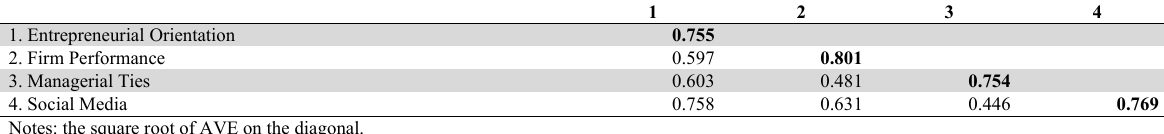
Fornell-Larcker Criterion